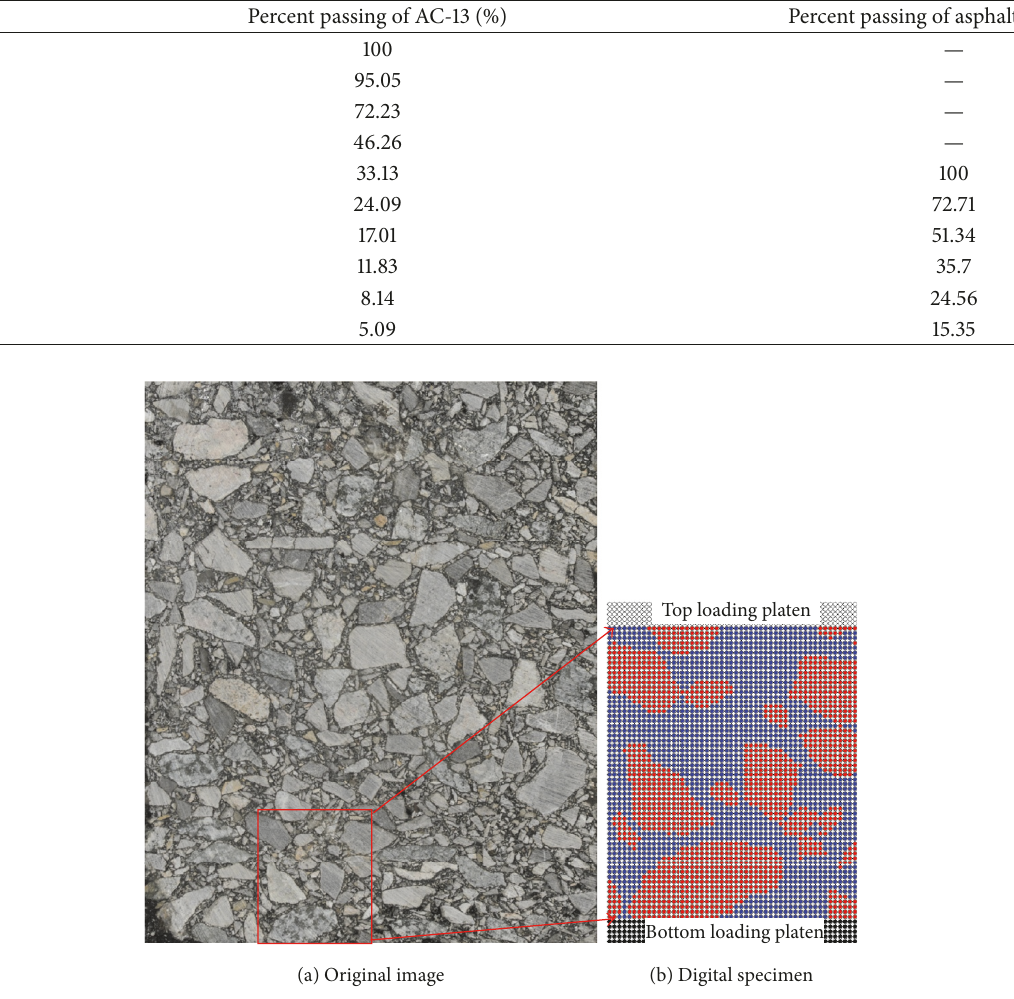
Figure 1: Reconstruction of digital specimen.